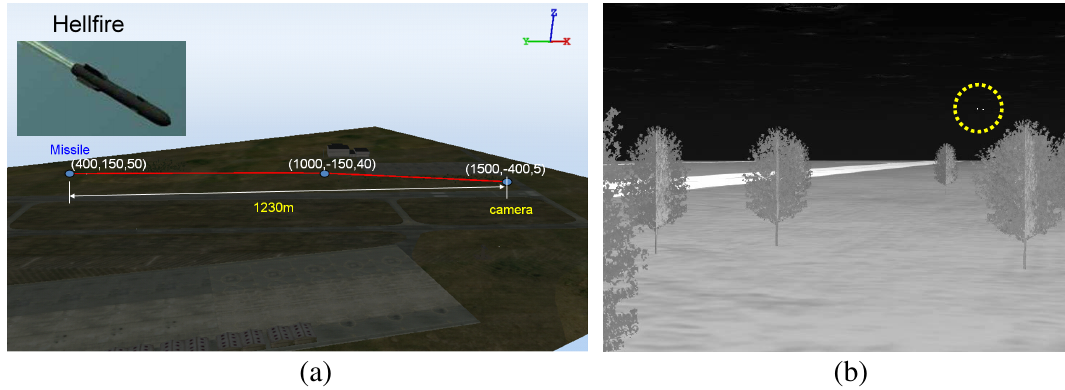
Figure 22. OKTAL-SE-based incoming target generation: ( a ) geometric scenario of incoming target using the Hellfire missile; ( b ) mid-wave IR image generation.